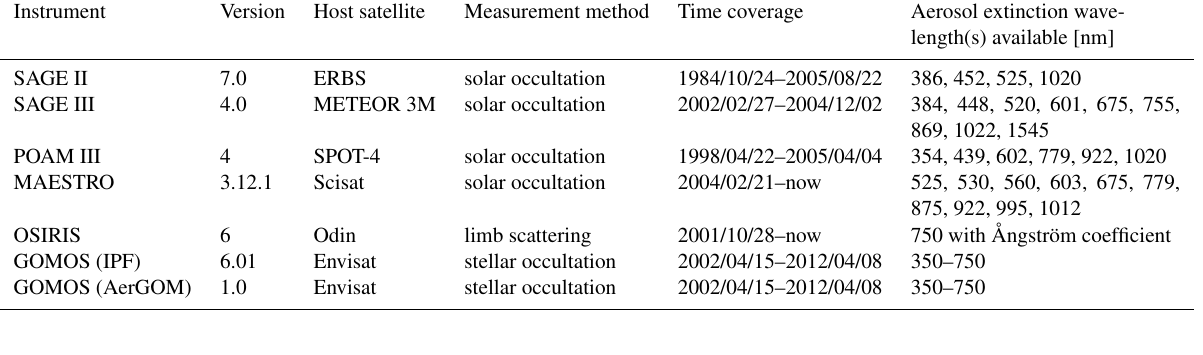
Table 1. Characteristics of the stratospheric aerosol extinction datasets used in this work.